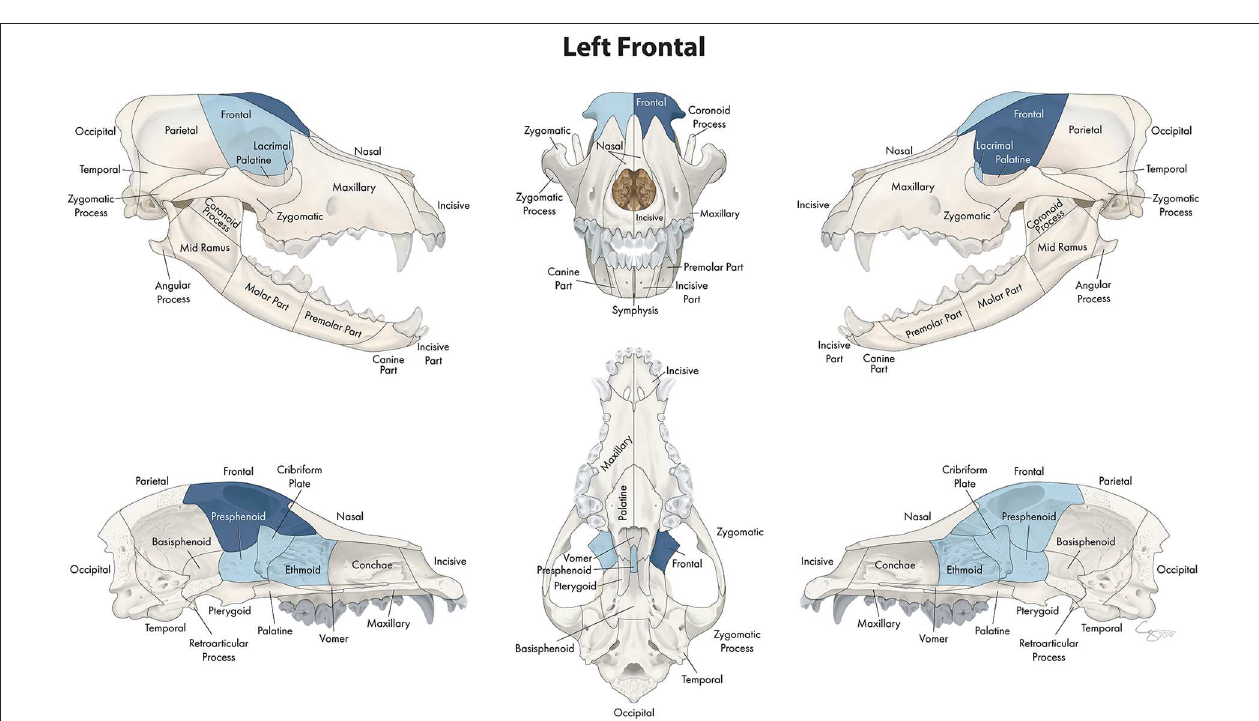
FIGURE 10 | Significant bones or regions fractured concurrently with the ethmoid bone. When the ethmoid bone was the region of interest, the conchae, cribriform plate, presphenoid bone, and bilateral pterygoid, frontal, lacrimal, and palatine bones fractured concurrently.